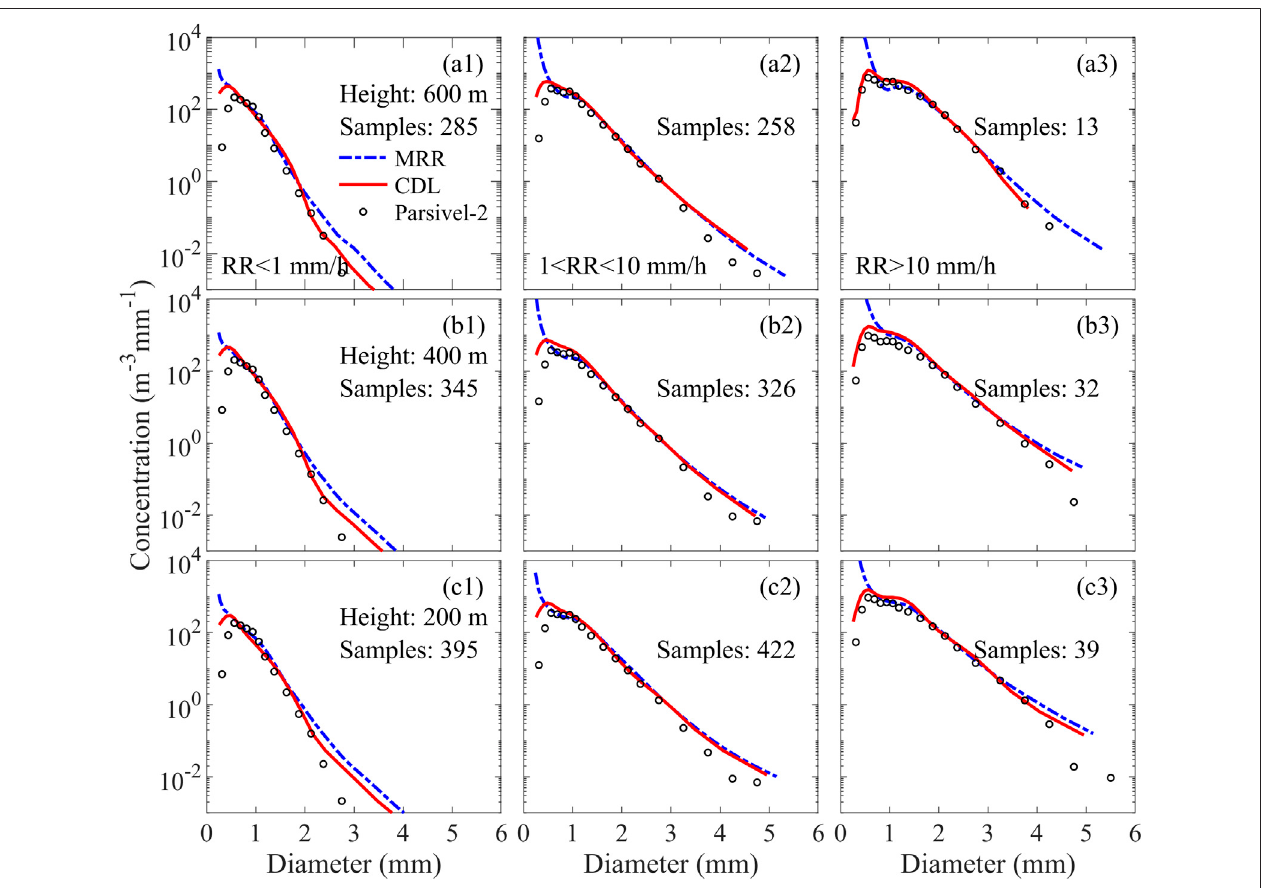
FIGURE 11 | Comparisons of the averaged raindrop size distributions between the detection of CDL, MRR, and the Parsivel-2: (A) RR < 1 mm/h and (B) 1 < RR < 10 mm/h conditions.